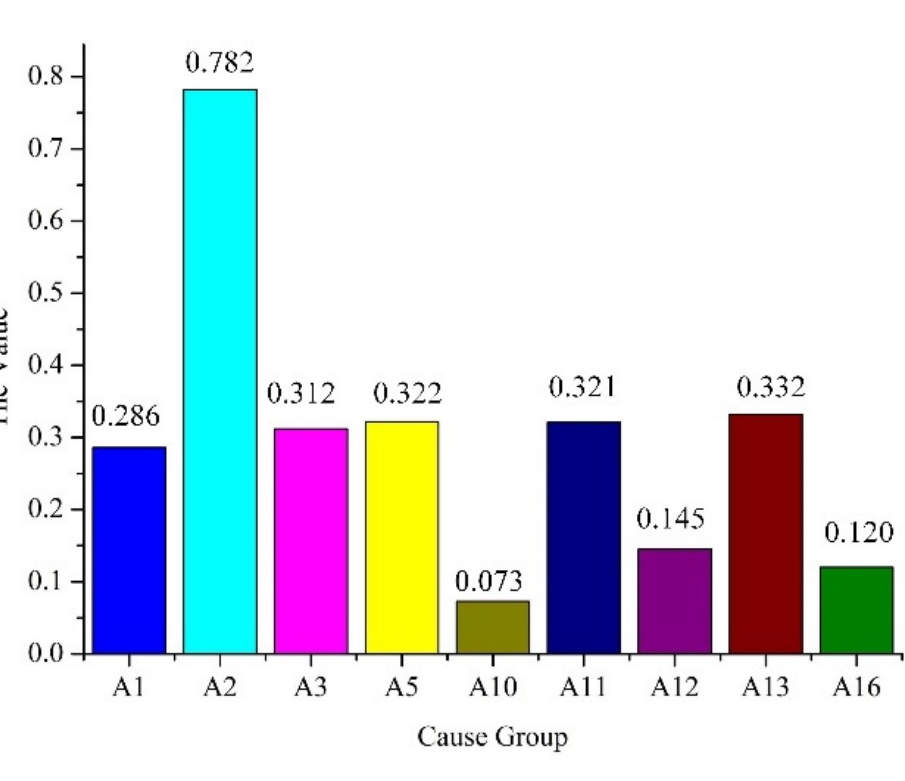
Figure 4. Causes group histogram. Table 8. The sequencing of the key drivers. Key